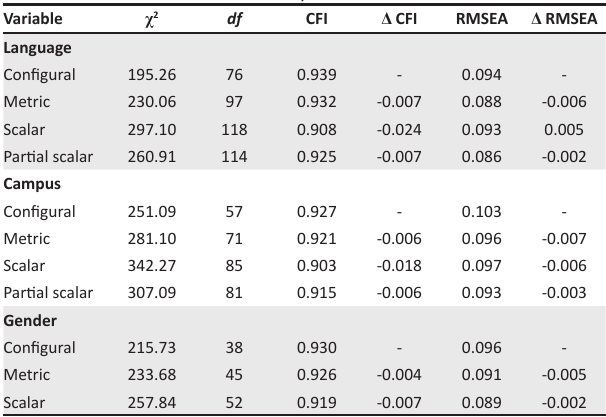
TABLE 3: Measurement invariance analysis.